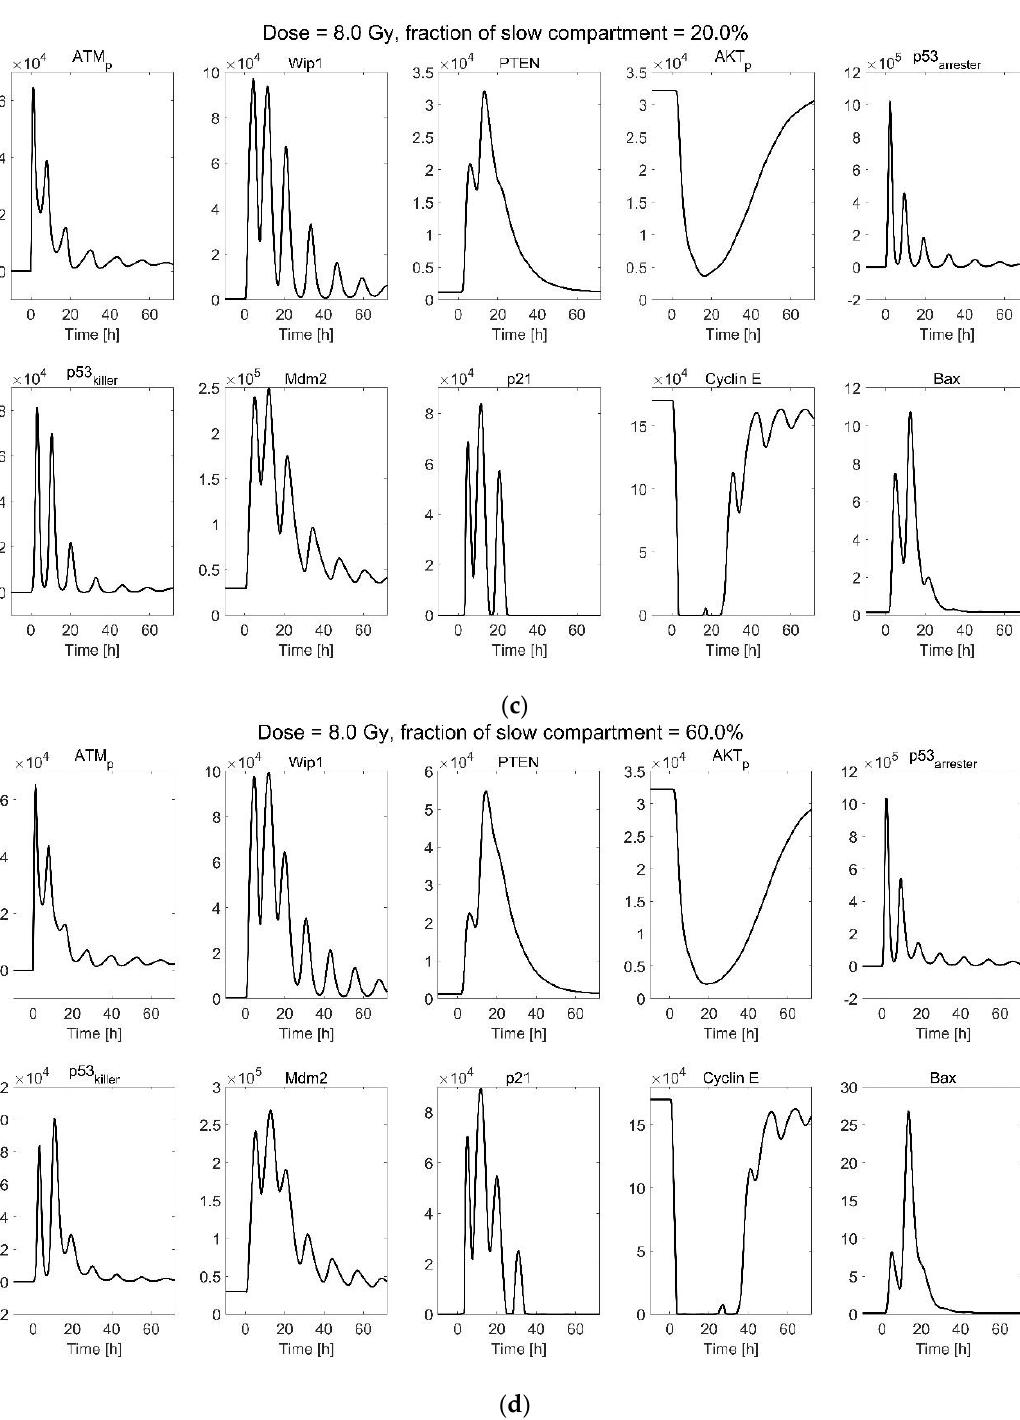
Figure 4. Deterministic simulation trajectories of the p53 system in response to ( a ) 2 Gy irradiation, 20% slow compartment; ( b ) 2 Gy irradiation, 60% slow compartment; ( c ) 8 Gy irradiation, 20% slow compartment; and ( d ) 8 Gy irradiation, 60% slow compartment. ATM p to Bax are proteins related to the p53 system; descriptions of them are listed in the Supplementary Materials, Table S1. The amplitudes of ATM p and phosphorylated p53 are similar for cells exposed to 2 Gy and 8 Gy because the activation of ATM by DSBs performs similar to a Hill mechanism so that the activation tends to saturate for a large number of DSBs [15]. The trajectories also show oscillations of phosphorylated p53, Mdm2, and Wip1, with a period of around eight hours. The oscillations are attributed to the negative feedback loops of ATM, p53,